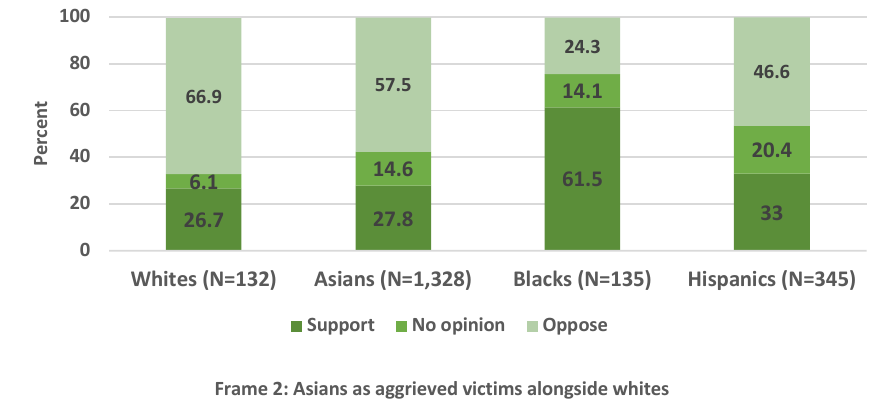
Asian Americans and Affirmative Action Figure 1: Attitudes on preferential hiring and promotion by frame and race. All figures are